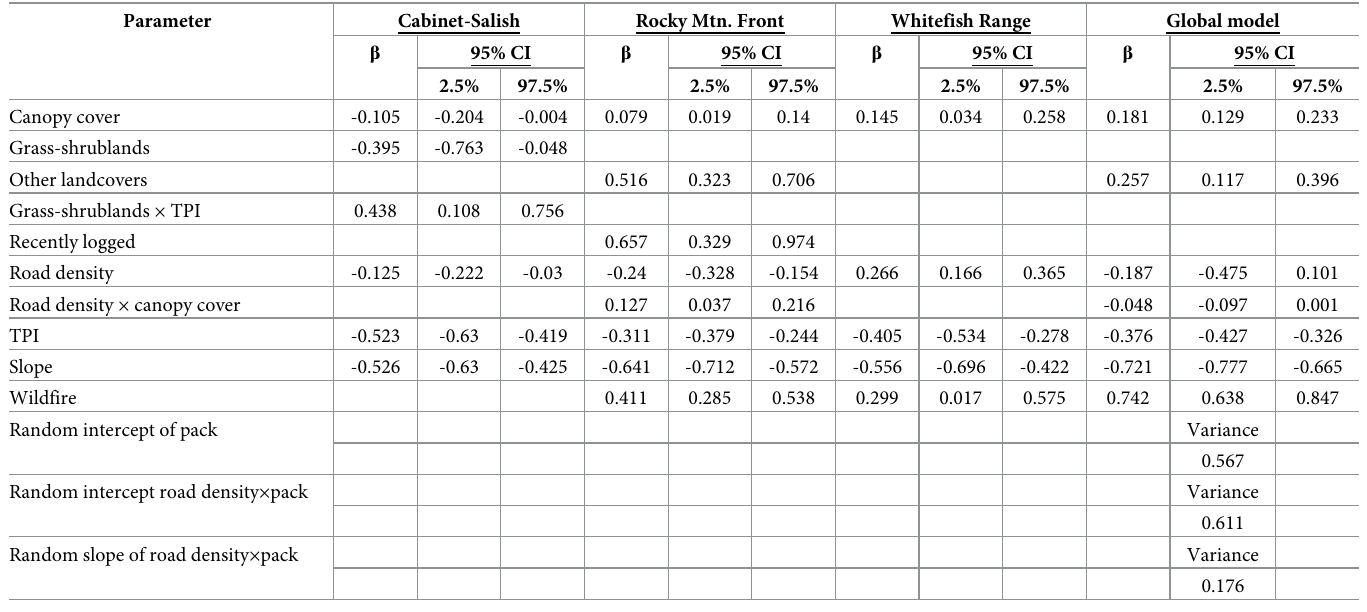
Table 2. Resource selection coefficients and confidence intervals (CIs) from top-ranked fixed effects and mixed-effects resource selection functions for wolves.